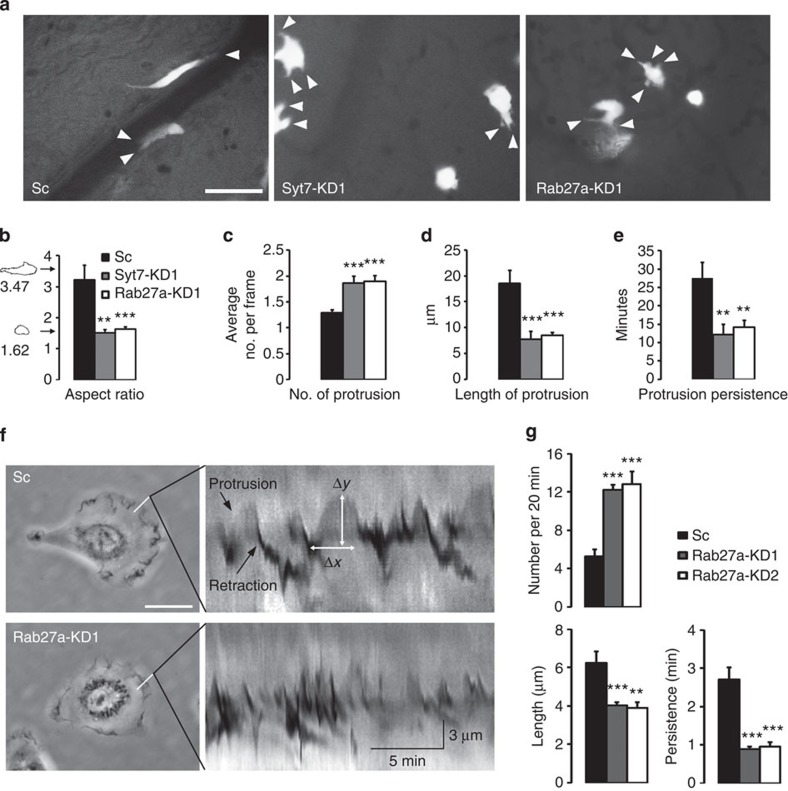
Endolysosomal secretion controls protrusion dynamics in vivo and in vitro(a–e) In vivo protrusion dynamics of HT1080 cells in the CAM (a) Representative images. Arrowheads indicate protrusions. Movies were recorded every 2 min for 60 min. Scale bar, 50 μm. See also Supplementary Movie 3. (b) Aspect ratio was calculated as length of major axis divided by length of minor axis of cell. Representative cell morphologies for high (3.47) and low (1.65) aspect ratios are shown at the left of the bar graphs. (c) Number of protrusions per cell was counted at each time frame (2 min) and averaged over movies (60 min). (d) Length of each protrusion. (e) Persistence of each protrusion was measured as the time between appearance and disappearance of each protrusion. n>30 cells for each cell line. (f,g) In vitro protrusion dynamics of HT1080 cells on tissue culture-treated dishes. (f) Representative kymographs. Note definitions of protrusion persistence (length of time that a protrusion lasts before retraction, Δx) and length of protrusion (Δy). Scale bar on Sc cell image indicates 30 μm. Scale bars on kymograph indicate time and distance axes. (g) Quantitation of number of protrusions/time, length of protrusion and protrusion persistence. n≥12 cells for each condition. Error bars, s.e.m. from three independent experiments. *P<0.05; **P<0.01; ***P<0.001 compared with Sc by Student's t-test.